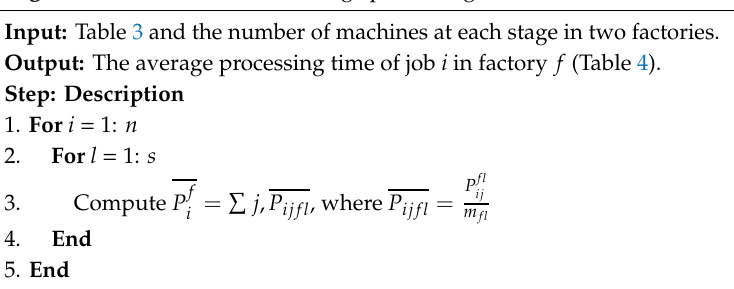
Algorithm 1. Calculation of average processing time.